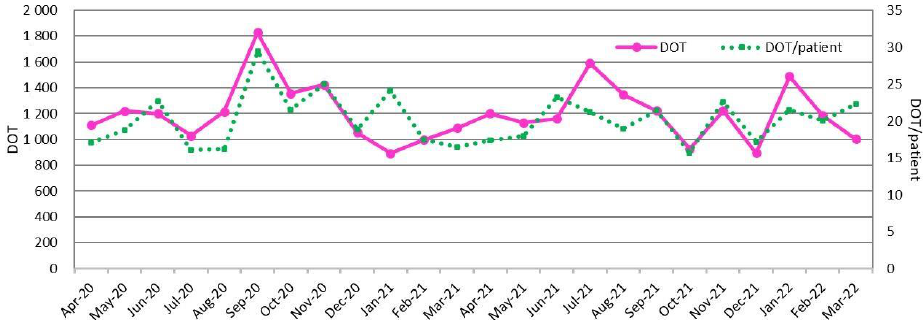
Figure 1. Monthly DASC and DASC/patient trends during this 2-year period. DASC, days of anti- biotic spectrum coverage.